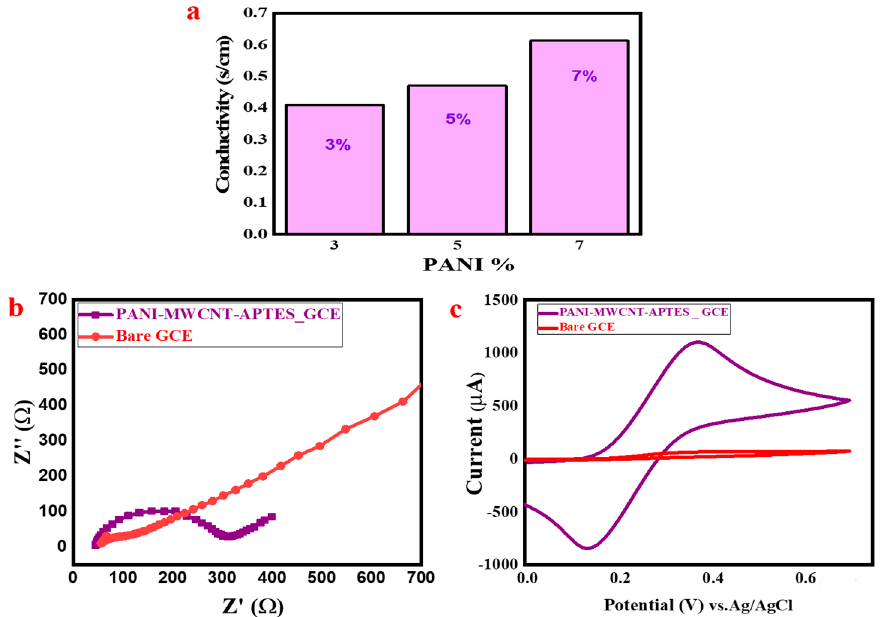
Figure 4. ( a ) A chart showing the electrical conductivity of the as-prepared PANI-MWCNT-APTES. ( b ) The obtained Nyquist plot for PANI-MWCNT-APTES. ( c ) The obtained CV in a ferricyanide couple (1 mM Fe (CN) 63-/4- prepared in 0.1 M KCl).